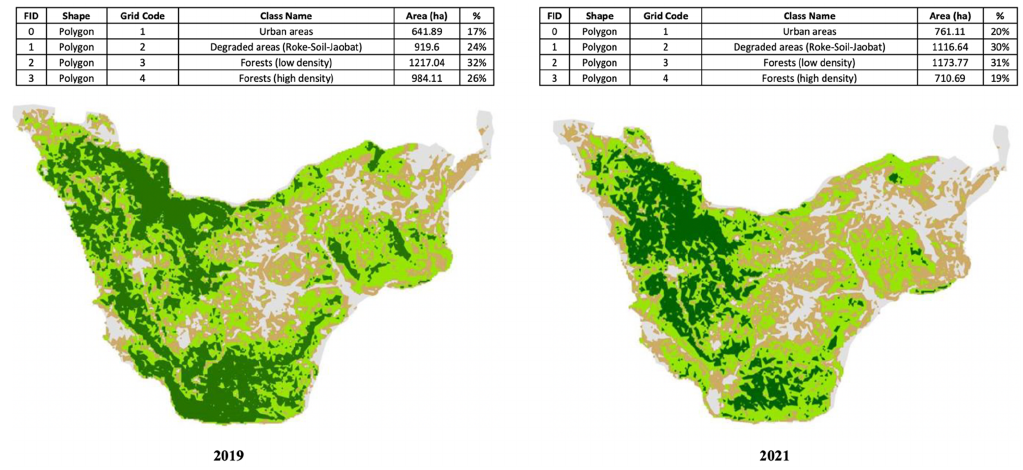
Figure 8. Change of vegetation in Abu Qubies protected area in 2019 and 2021.